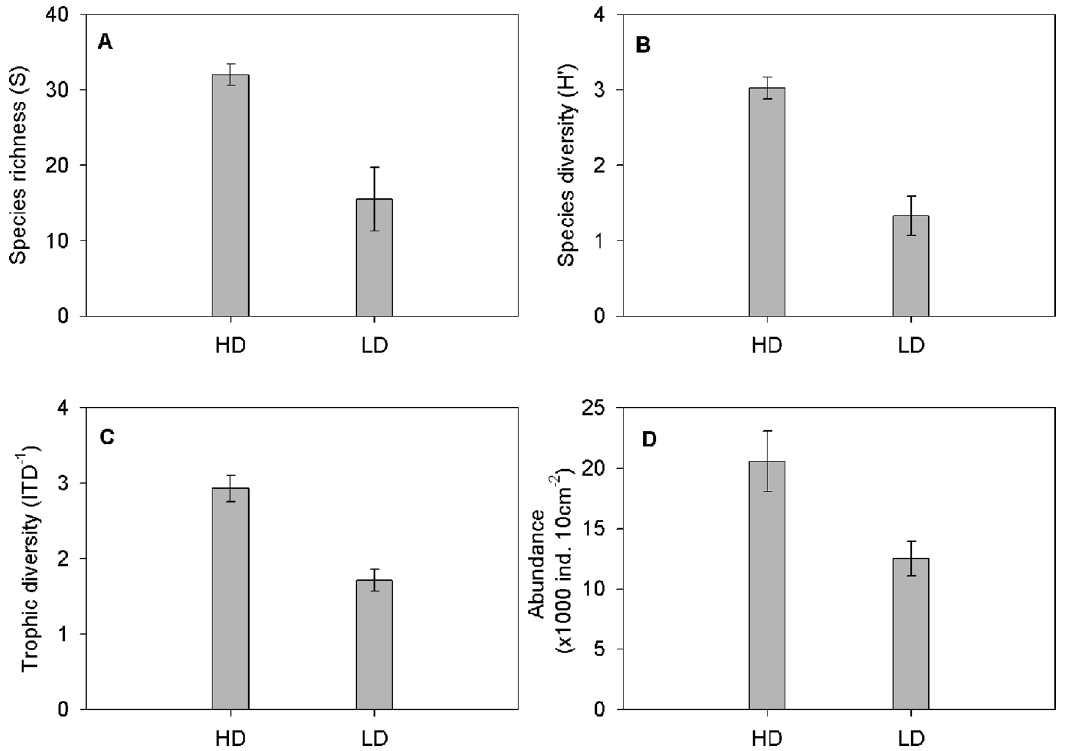
Figure 3. Comparison of the two field assemblages. Mean ( 6 Standard deviation) of A: Species richness ( S ), B: Diversity ( H’ ; Index of Shannon Wiener), C: Trophic diversity ( IDT 2 1 ), and D: Abundance (individuals per 10 cm 2 ).